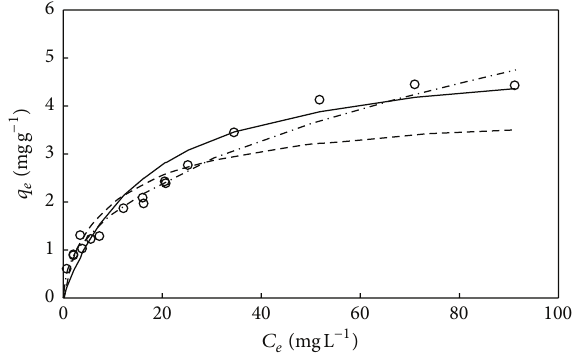
Figure 6: The simulations of Langmuir isotherm (—), Freundlich isotherm (- ⋅ -), and D-R isotherm (---) for adsorption of DMP on M- PVAL. pH 0 = 6.04–6.64. Final pH = 6.9–8.05. I : experimental data. by ¨Ozcan et al. for the adsorption of ion-exchange form [49].